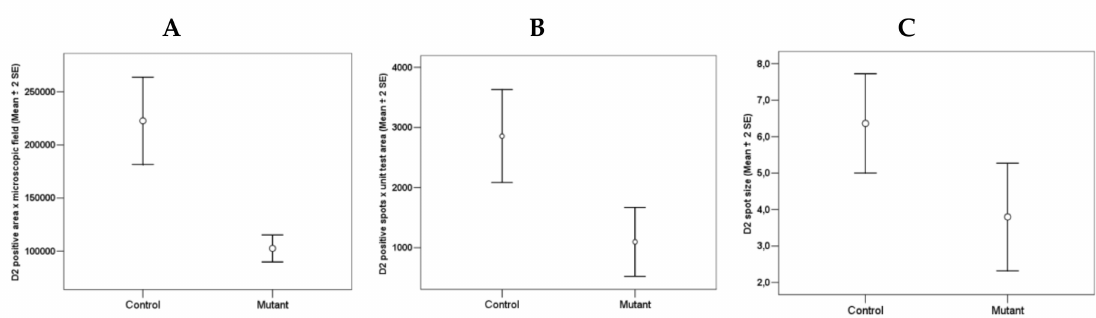
Figure 5. Comparative densitometric analysis of the D2 immune-fluorescence in the striatum of control Tor1a +/+ and mutant Tor1a +/ − knock-out transgenic mice. ( A ) Total D2 positive area per microscopic field through 63 × oil immersion objective. df = 1, F = 31.202; p < 0.0001. ( B ) Number of D2 positive disks